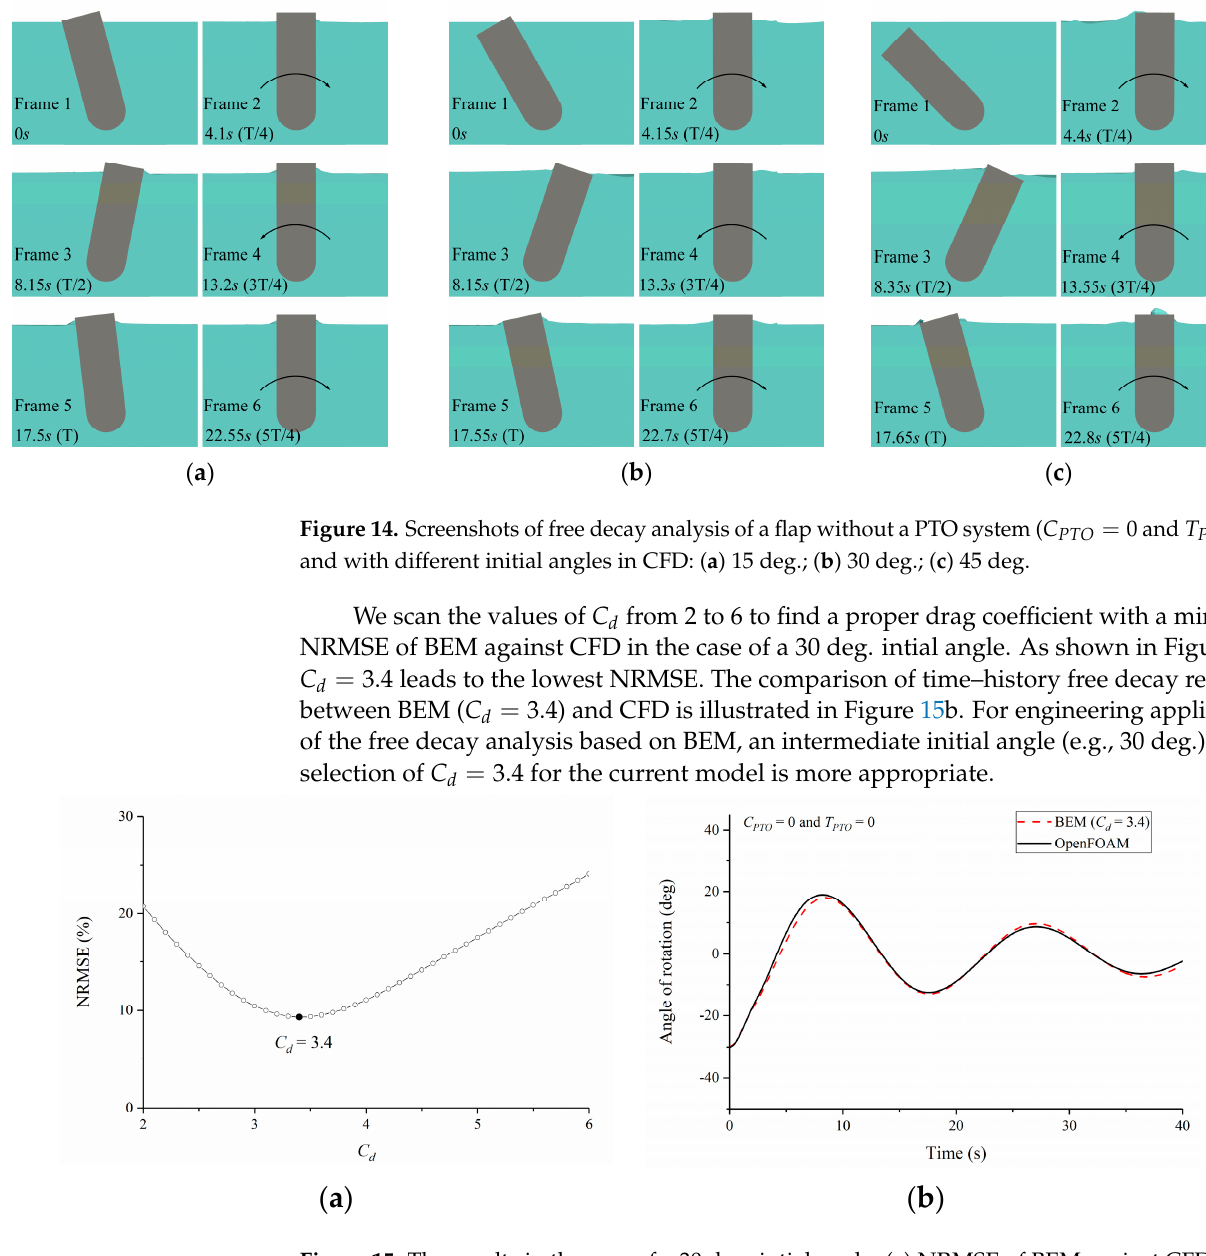
( b ) comparison of time–history free decay response between BEM ( 𝐶 (cid:3031) = 3.4 ) and CFD.